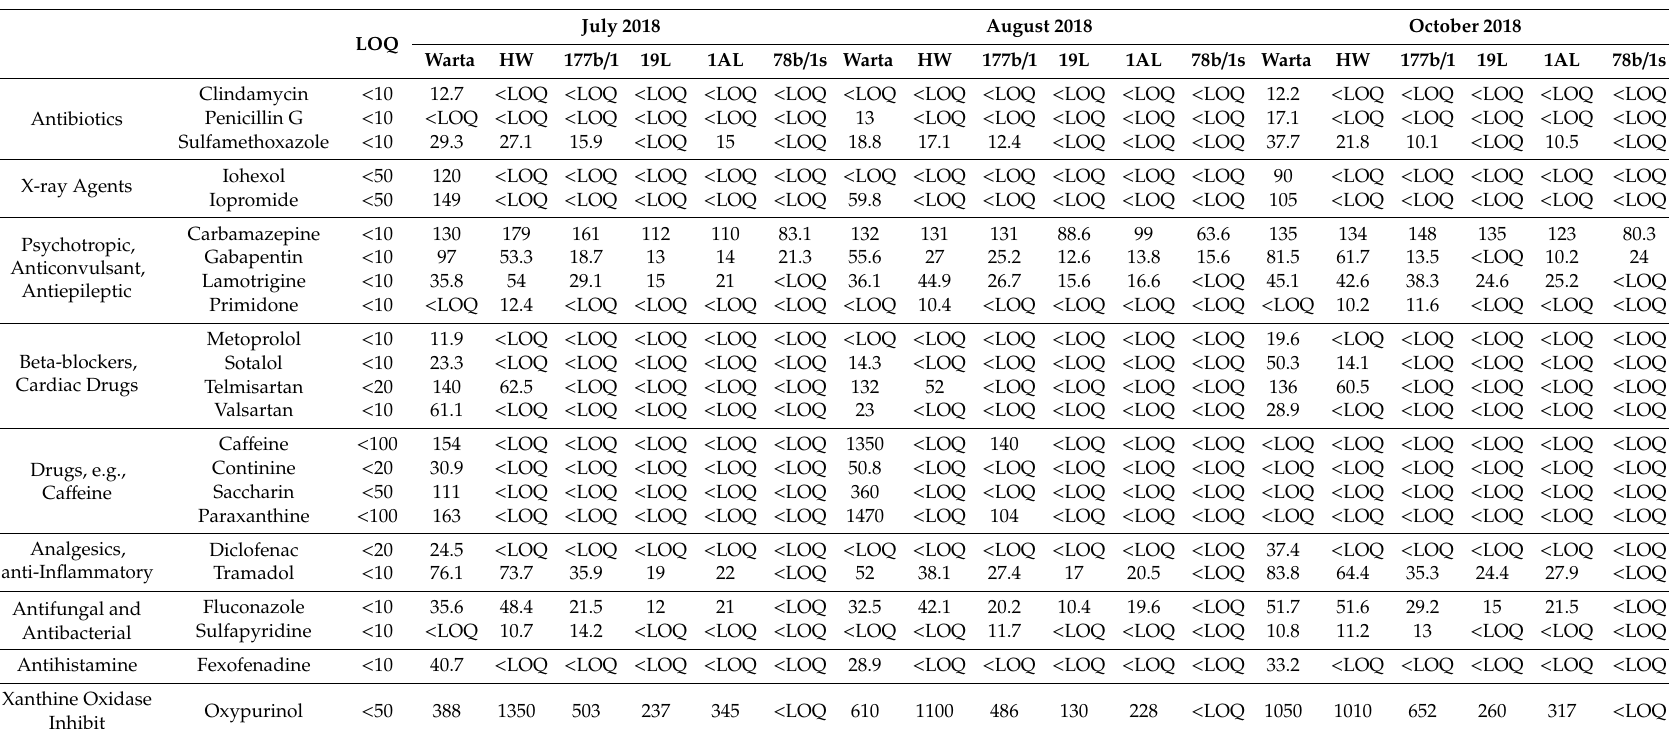
Table 4. Concentrations of pharmaceuticals in ng / L: Extended investigations. HW - Horizontal well, < LOQ - below limit of quantification. Measurements performed in VHL